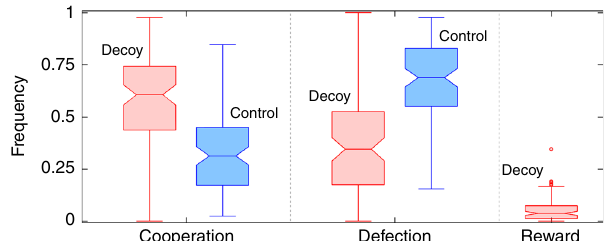
Fig. 1 Reward ignites cooperativeness. Median frequency of cooperation equal to 60.5% in the decoy treatment is signi fi cantly higher (one-tailed Mann – Whitney U test; z -score 5.6713; p value < 10 − 8 ) than the median frequency of cooperation equal to 31.4% in the control treatment.